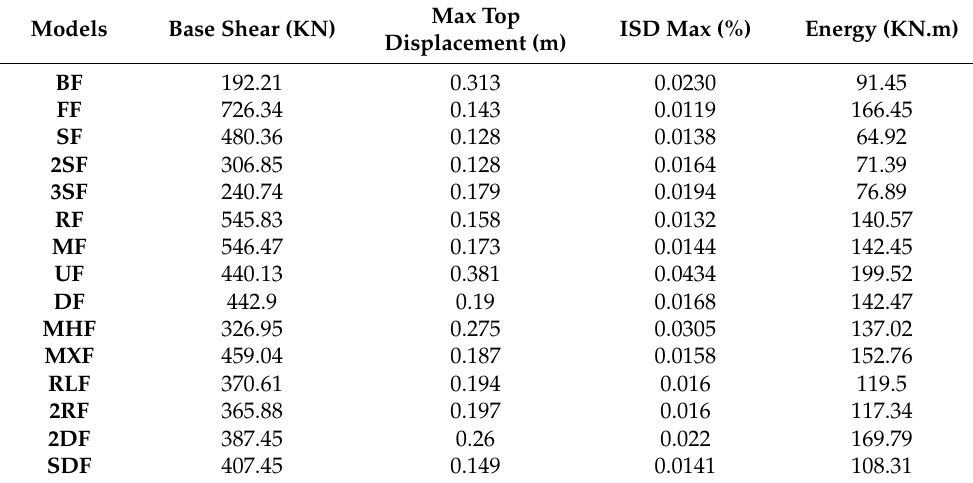
Table 5. The values of maximum top displacement, maximum base shear, maximum inter-story drift and the energy of the plastic deformation damping for the models studied.